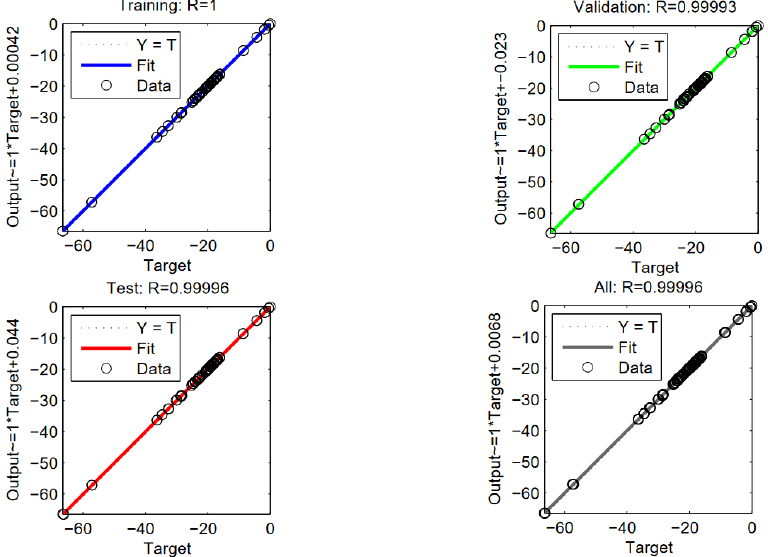
Figure 33. Regression plot of the network (for the periodic array